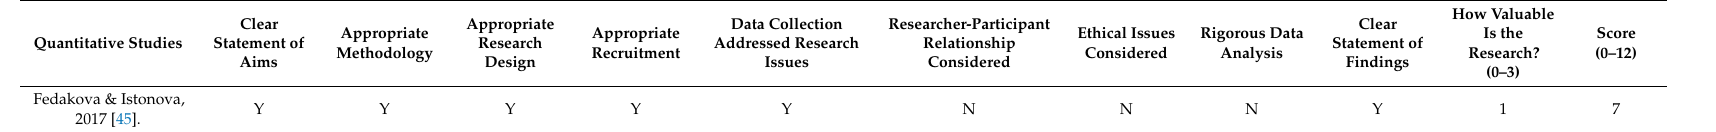
Table 8. Assessment of risk of bias for qualitative